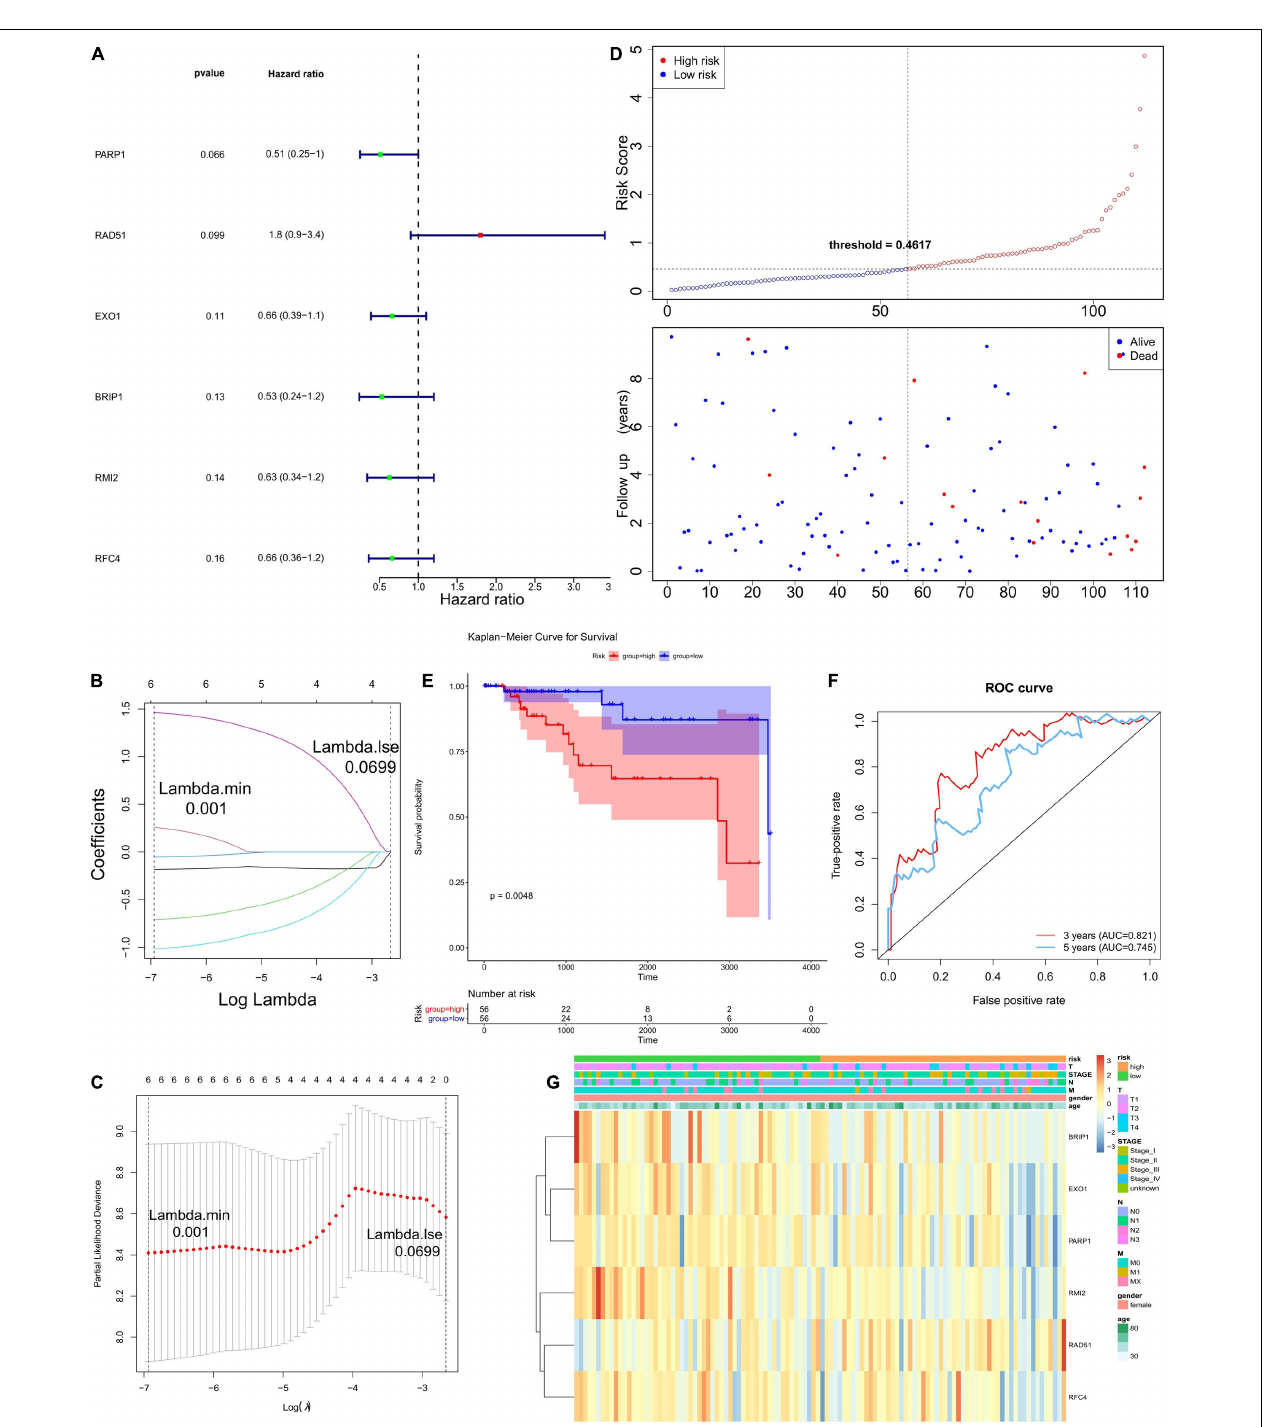
FIGURE 2 | Establishment and evaluation of the prognostic model. (A) The forest plots illustrate univariate Cox analysis of the six genes significantly associated with OS. (B,C) LASSO coefficient profiles of six genes significantly associated with OS. (D) The Risk curve of the risk model. The risk value of patients increases from left to right. According to the median value, the samples were divided into high- and low-risk groups. (E) K–M survival curve of the Risk score. In the figure, the ordinate indicates the survival rate, and the abscissa indicates the total survival time. The red curve represents the high-risk group, and the blue curve represents the low-risk group. The difference between high- and low-risk groups was 0.0048, indicating a significant difference. (F) The ROC curve used to evaluate the effectiveness of the risk model. (G) The top of the heat map shows different clinical characteristics, in which the first line denotes the high-low risk grouping, orange represents the low-risk group samples, and green represents the high-risk group samples. The tree on the left shows the clustering analysis results of different genes from different samples.